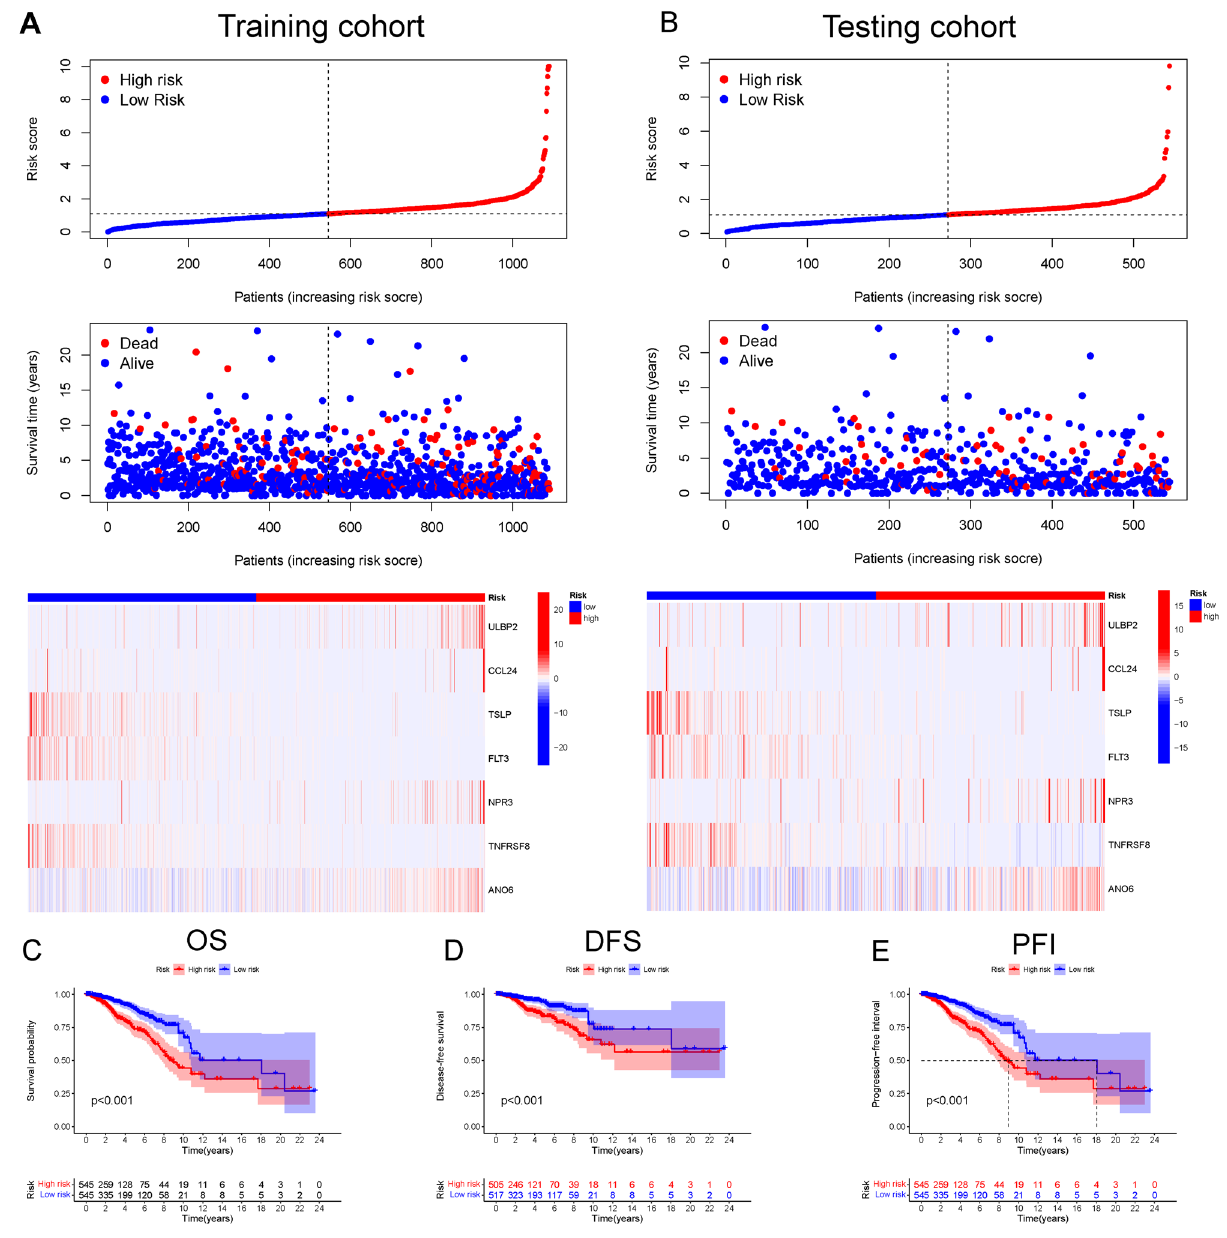
Figure 2. The distribution of risk score, survival status, and mRNA expression panel in the training cohort and testing cohort. In the training cohort ( A ) and testing cohort ( B ), the risk score of breast cancer (BC) patients was closely related to survival status and expression panel. Kaplan–Meier survival analysis was conducted to evaluate the differences of overall survival (OS), disease-free survival (DFS), and progression-free interval (PFI) in the high- and low-risk groups based on the “survival” and “survminer” R packages. In the training cohort, Kaplan ‒ Meier curves revealed the OS ( C ), DFS ( D ), and PFI ( E ) of BC patients in the high-risk group compared with those in the low-risk group. BC breast cancer, OS overall survival, DFS disease-free survival, PFI progression- free